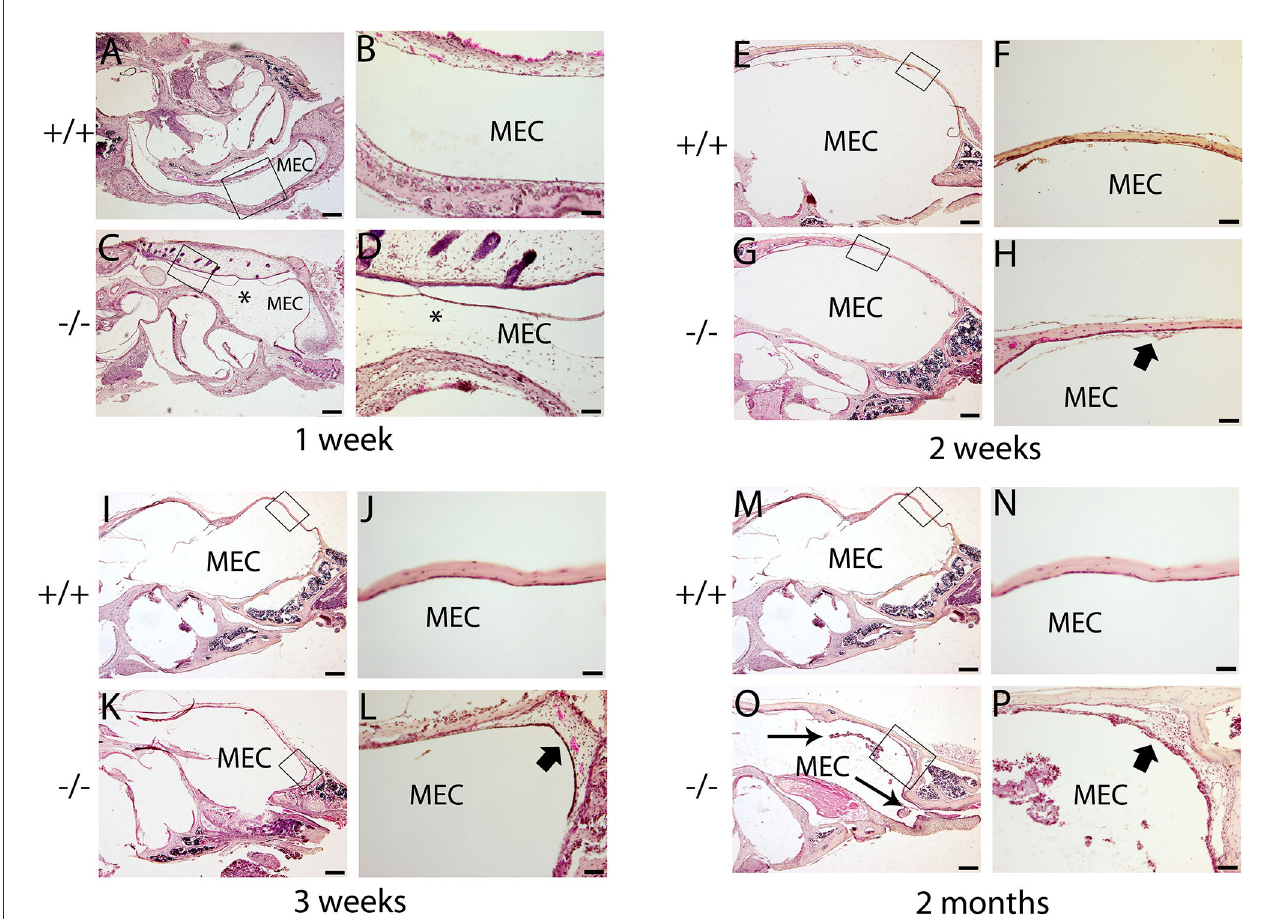
FIGURE5 Hematoxylin and eosin (H&E) histology shows the development of middle ear structures and pathology. Wild type ( + / + ) and mutant mice (-/-) were observed for the morphology of the middle ear at each time point ( n = 4 for each genotype). In each row, the right panel represents the enlarged image corresponding to the rectangular region on the left. (A–D) Representative images of mice at the age of 1 week. The middle ear cavity (MEC) was filled with mesenchymal cells [asterisk, (C, D) ] in mutant mice, whereas the middle ear cavity was large and clean in wild-type mice (A, B) . (E–H) : Representative images of mice at the age of 2 weeks. The mesenchymal cells disappeared in mutant mice, and the middle ear cavity was clean in both groups (E, G) . The mucosa of the middle ear cavity becomes thicker (short arrow) in mutant mice compared with the monolayer epithelium in wild-type mice (F, H) . (I–L) : Representative images of mice at the age of 3 weeks. There was no obvious effusion in mutant mice, compared with the wild-type mice (I, K) . The mucosa and submucosa hyperplasia (short arrow) developed further and capillary proliferation occurred in the mutant mice (L) . (M–P) : Representative images of mice at the age of 2 months. In wild-type mice, neither effusion nor inflammation was detected, and the middle ear cavity was covered with monolayer epithelium (M, N) . In mutant mice, inflammatory infiltration and debris pervaded the middle ear cavity (long arrow), the mucosa and submucosa hyperplasia progressed to a much greater severity (short arrow), and as regards the capillary proliferation and expansion, the Eustachian tube exhibited general thickening with the proliferation of epithelial cells (O, P) . Scale bars: 200 µ m (A, C, E, G, I, K, M, O) ; 50 µ m (B, D, F, H, J, L, N, P) . MEC, middle ear